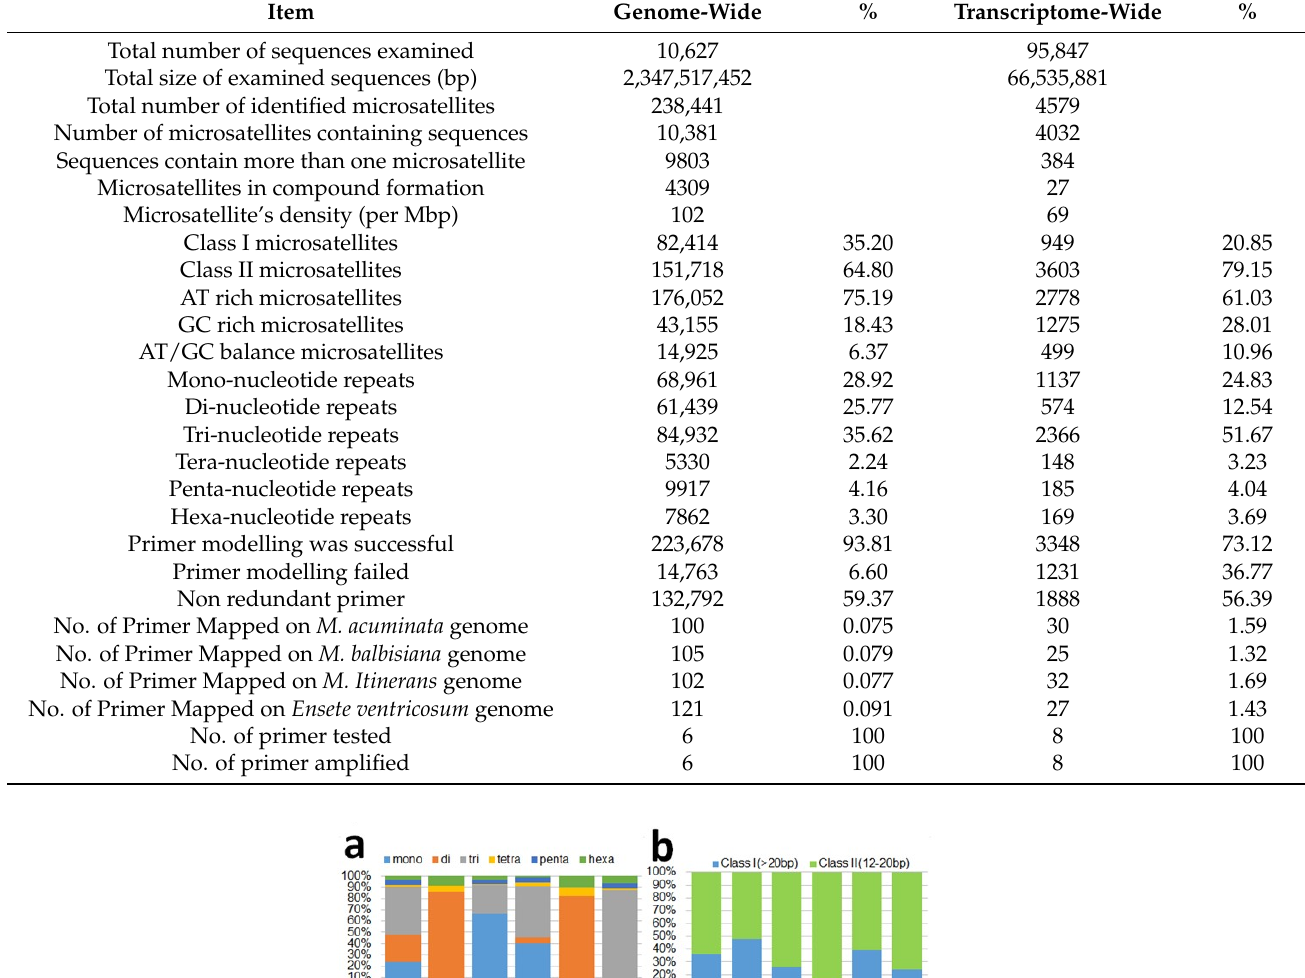
A. thaliana and M. acuminata (Figure S8). Functional annotation of the 73,102 predicted proteins from B. rotunda against seven databases enabled functional predictions for 97.8% of the predicted genes (Table 6). Non-coding RNA analysis of the assembly identified 2136 small nuclear RNA (snRNA) genes (Table 7). Table 5. Genome and transcriptome-wide microsatellite identification and characterization in B. rotunda .